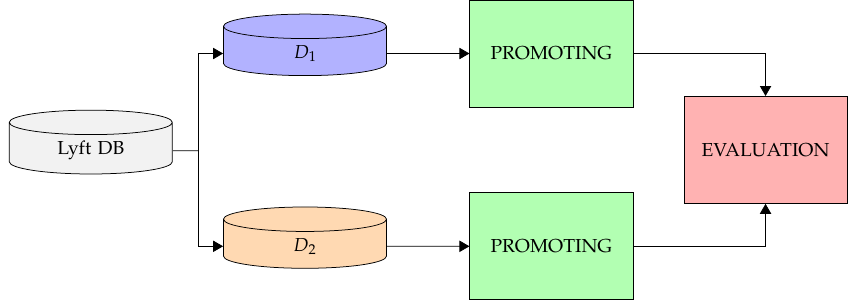
Figure 13. Shown is an overview of the evaluation process of the PROMOTING method. Figure 13. An overview of the evaluation process of the PROMOTING method.